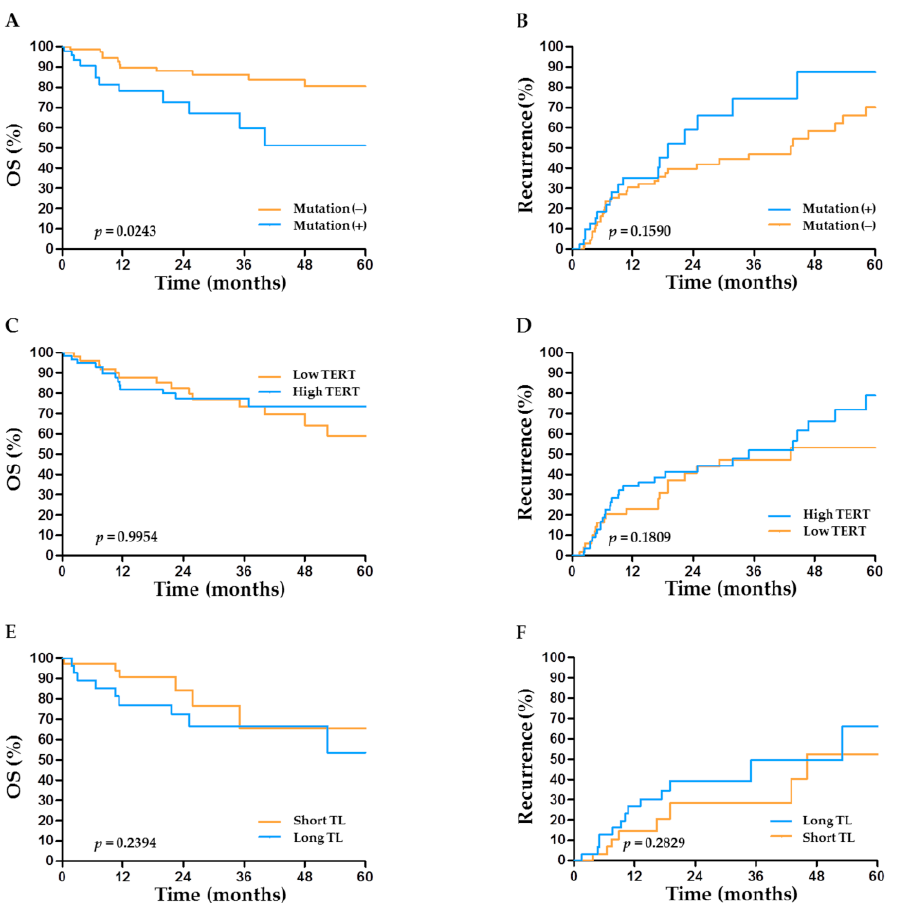
Figure 3. Prognostic role of TERT factors in the outcome of HCC after hepatectomy. Overall survival (OS) and HCC recurrence according to ( A , B ) the status of TERT promoter mutations, ( C , D ) the expression level of TERT , and ( E , F ) telomere length.